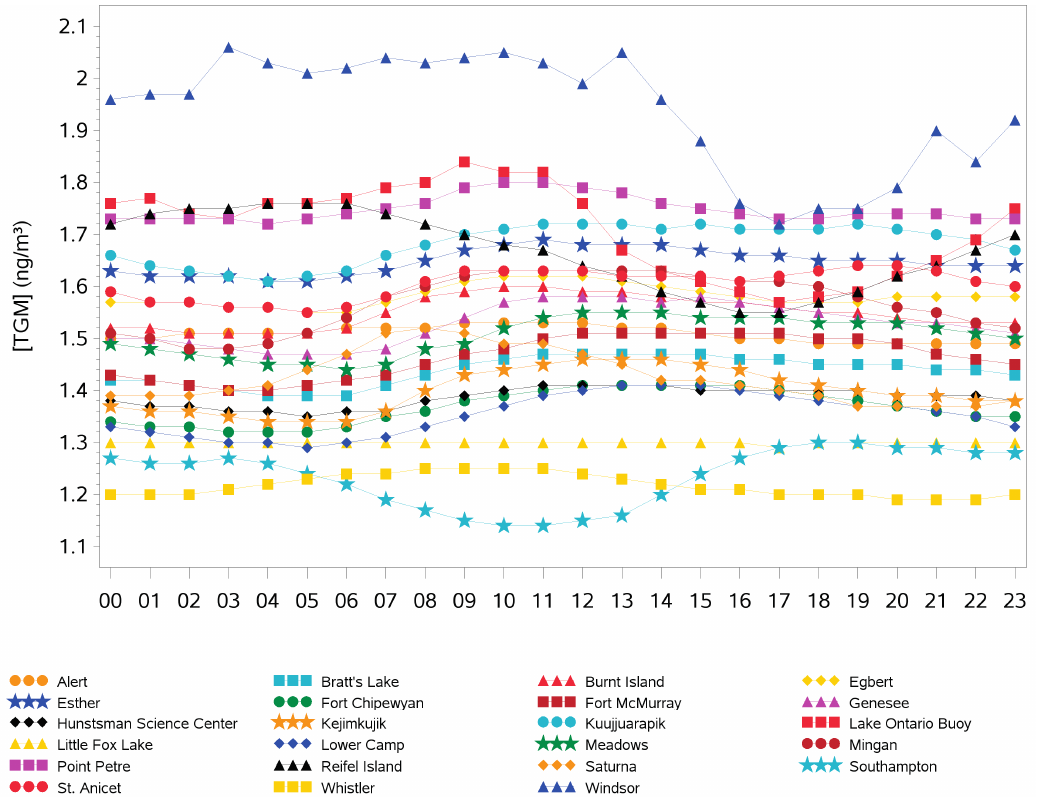
Figure 5. Diel cycles in TGM averaged over total measurement period at all sites. Hour 0 is from 12:00 to 1:00 a.m. local